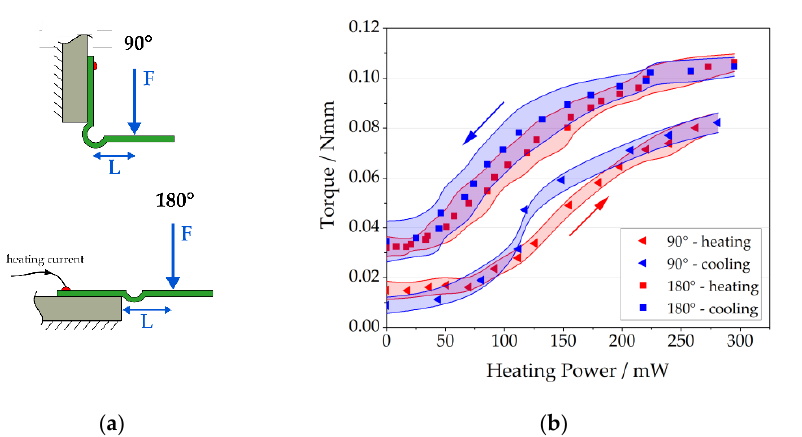
Figure 7. Measurement of blocking force versus folding angle of a single self-folding microactuator: ( a ) Schematic of experimental setup for the case of 90° and 180° folding angle; the resulting torque is obtained by the product of measured force F and distance L with respect to the fixation; ( b ) torque versus heating power characteristics upon heating and cooling.